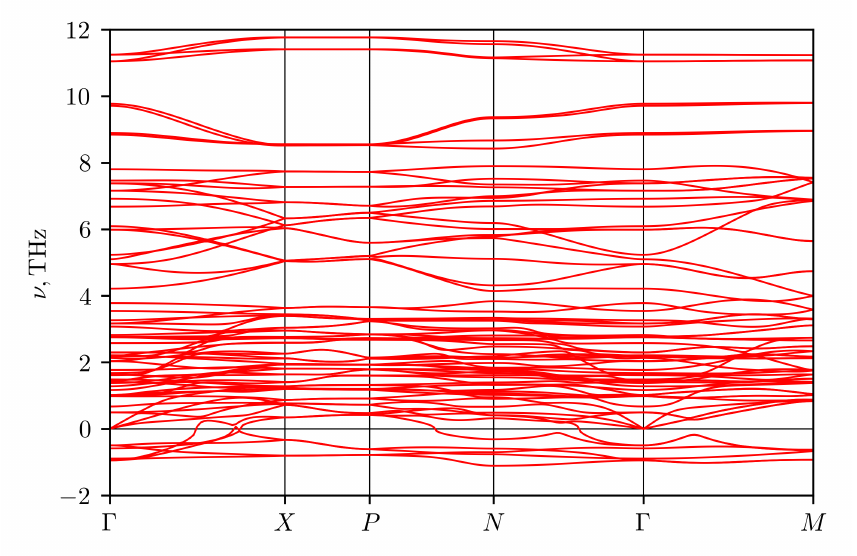
Figure 12. Phonon spectrum of Ag 3 CuS 2 (I4 1 /amd), calculated at zero temperature, using equilibrium lattice parameters and PBEsol density functional approximation [28].